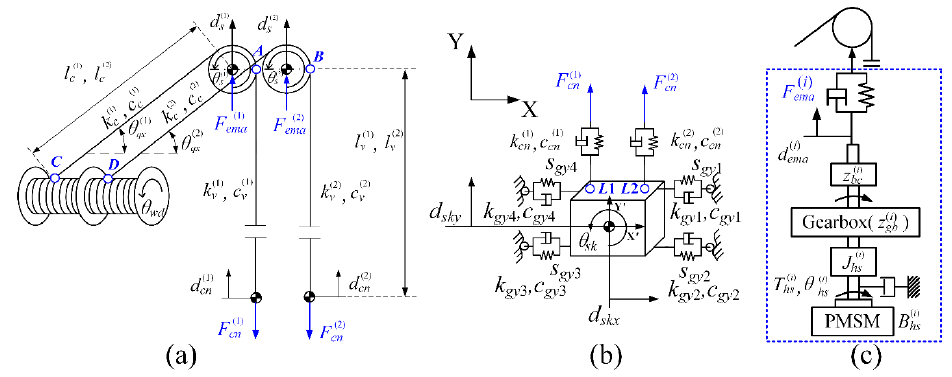
Figure 2. Mine hoist dynamic model. ( a ) Hoisting subsystem model; ( b ) Skip subsystem model; ( c ) Electric drive actuator model.